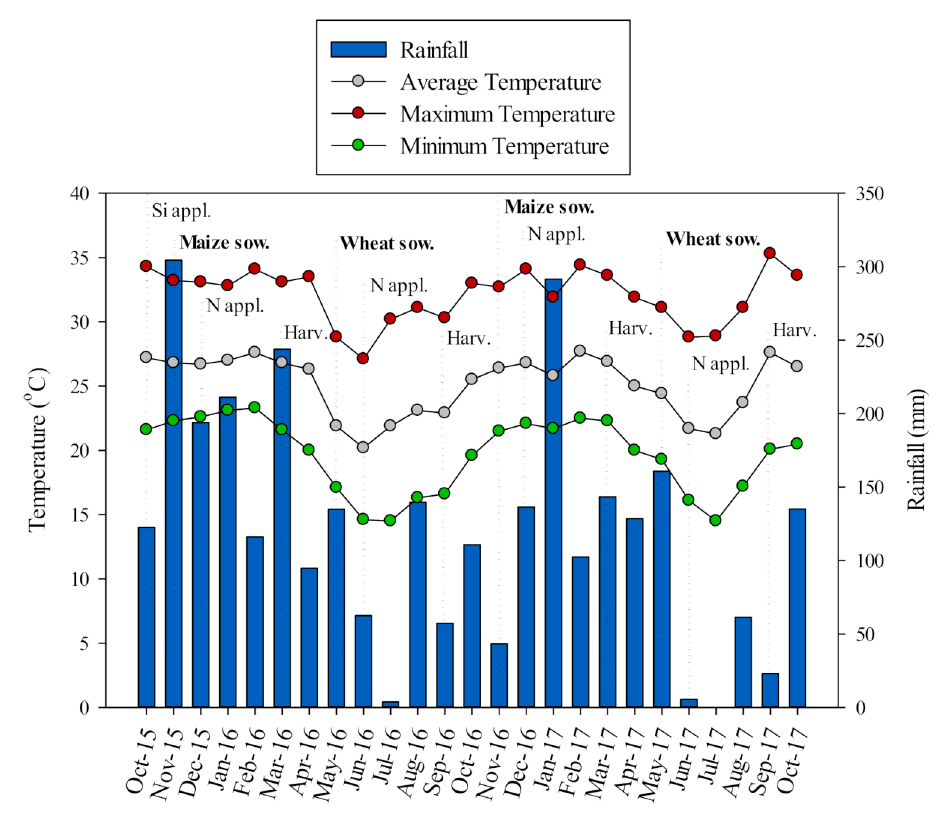
Figure 5. Rainfall, and temperatures (minimum, average and maximum) obtained from the weather station located in the Education and Research Farm of College of Engineering of Ilha Solteira/S ã o Paulo State University (FEIS/UNESP) during the period of October 2015 to October 2017. Vertical dotted lines represent the Si-amendment source application, maize and wheat sowing, N application in side-dressing and harvest dates,